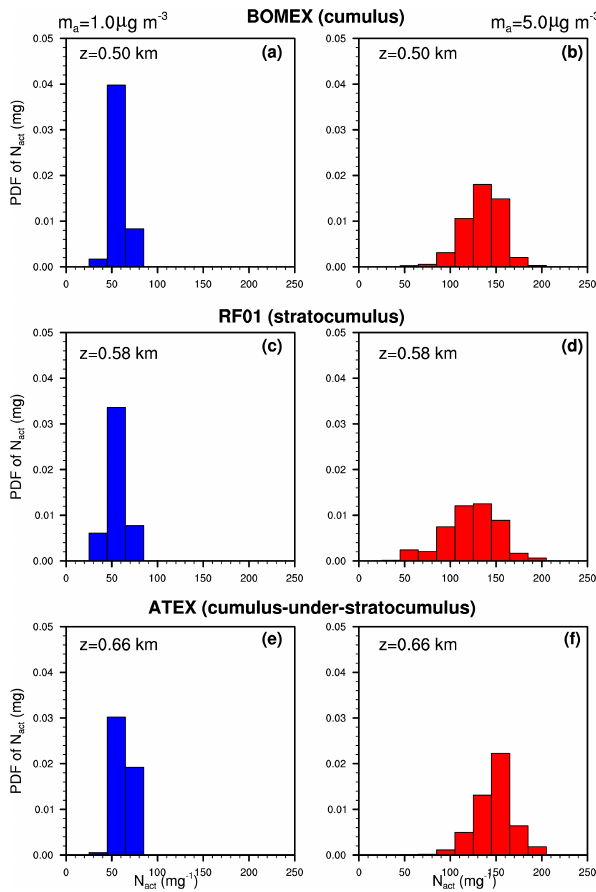
Fig. 5. Probability density function (PDF) of N act at different sul- fate concentrations ( m a ) near cloud bases averaged over the same periods as in Fig. 2 for BOMEX in (a) and (b) , RF01 in (c) and (d) , ATEX in (e) and (f) , RICO in (g) and (h) , and RF02 in (i) and (j) .